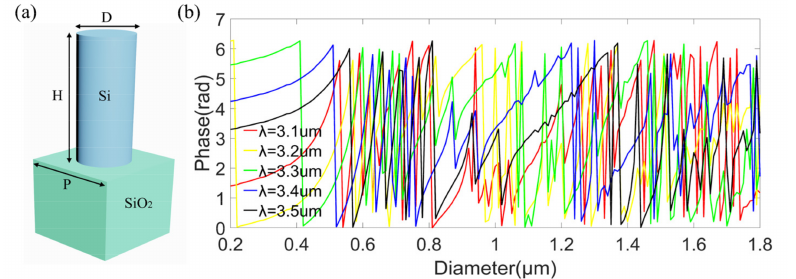
Figure 4. ( a ) Schematic of the unit cell, composed of a silicon nanopillar on fused silica substrate. ( b ) The phase shifts as functions of the nanopillar diameters at wavelengths of 3.1 µ m (red line), 3.2 µ m (yellow line), 3.3 µ m (green line), 3.4 µ m (blue line), and 3.5 µ m (black